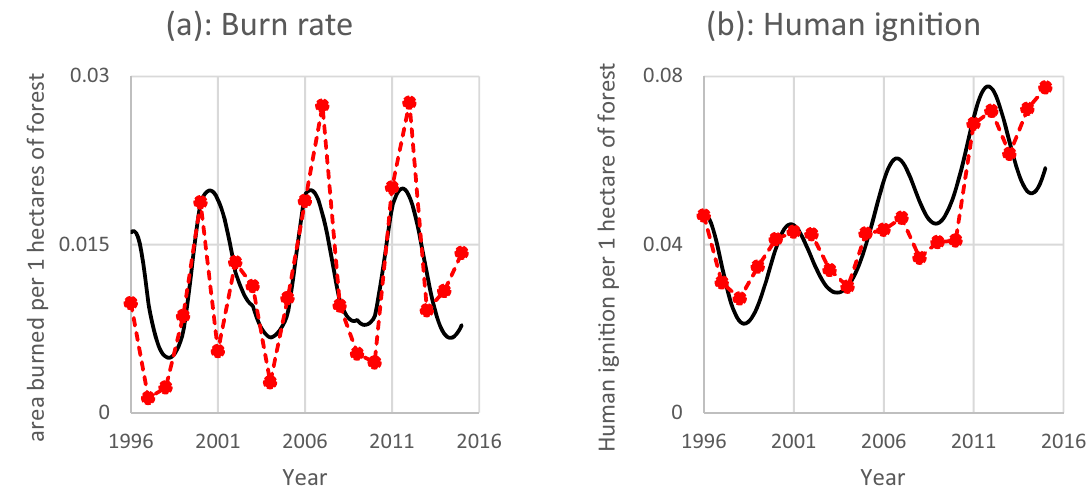
Figure 9. Burning rate and human ignition per unit of forest area. The black line represents the model result, and the red dotted line represents the historical wildfire activity in the conterminous United States.